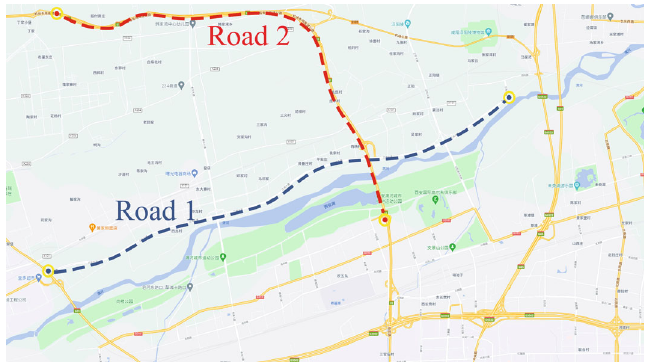
Figure 3: Experimental route.